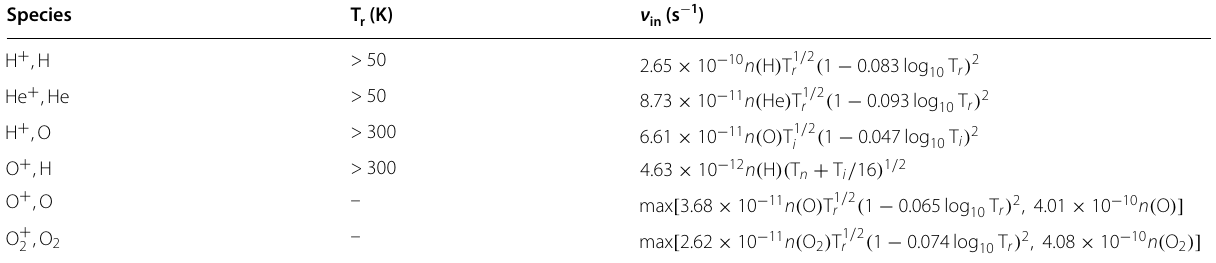
Table 2 Resonant ion-neutral collision frequencies. Densities are in cm − 3 . Ion temperatures (T i ) and neutral temperatures (T n ) are in Kelvin Species T r